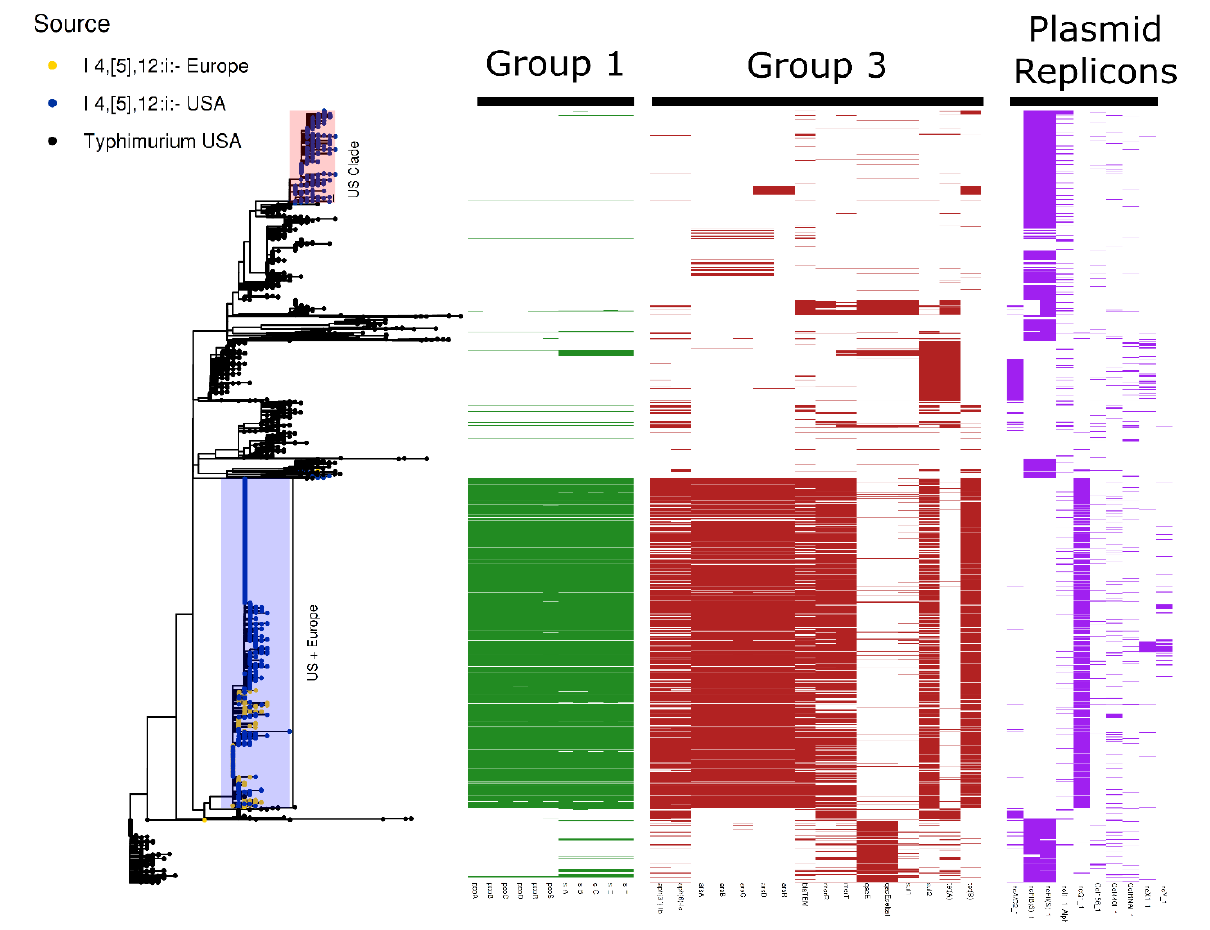
Figure 4. Distribution of Group 1, Group3, and major plasmid replicons in S. enterica I 4,[5],12:i:-. A presence-absence matrix for each gene group is plotted against a maximum-likelihood tree of S. enterica Typhimurium and S. enterica I 4,[5],12:i:- rooted on S. enterica Typhimurium DT104 NCTC 13348. Two major clades of S. enterica I 4,[5],12:i:- are observed, one clade which contains both US and European isolates contains both group 1 and 3 genes and the IncQ1_1 plasmid replicon in a high proportion.